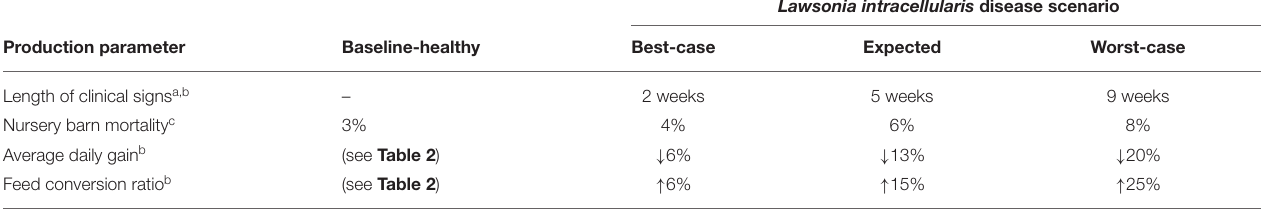
TABLE 3 | Production impact of L. intracellularis on a 1,000-sow farrow-to-finish hog farm.